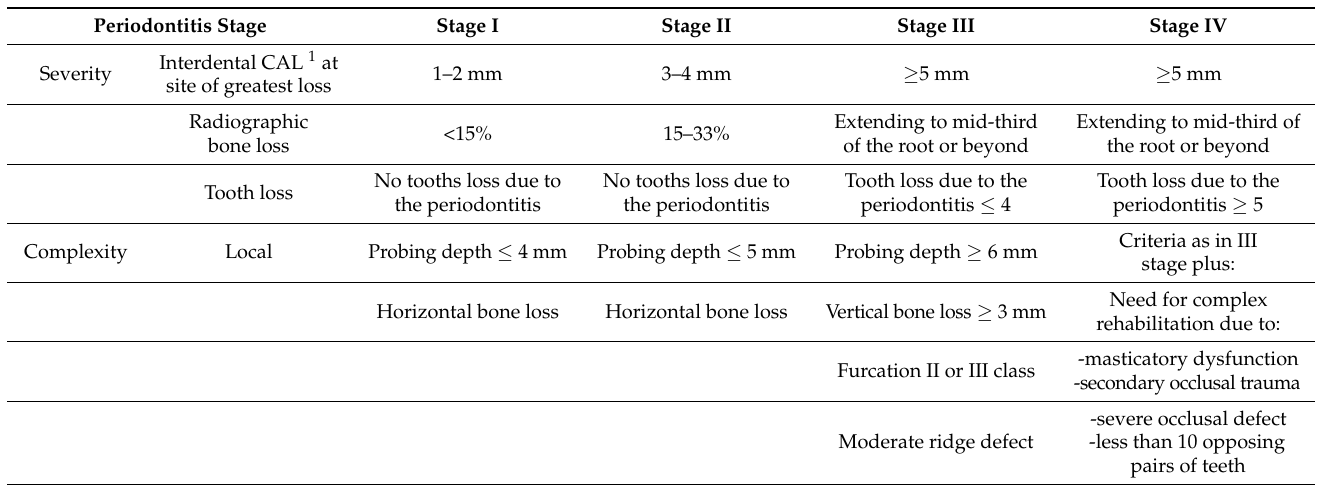
Table 1. Periodontitis